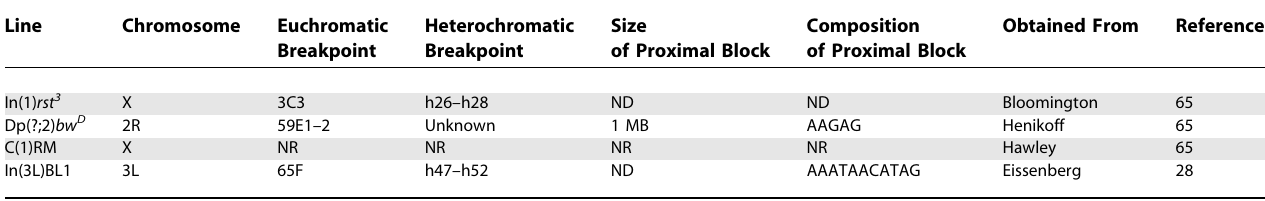
Table 2. List of Rearranged Chromosomes